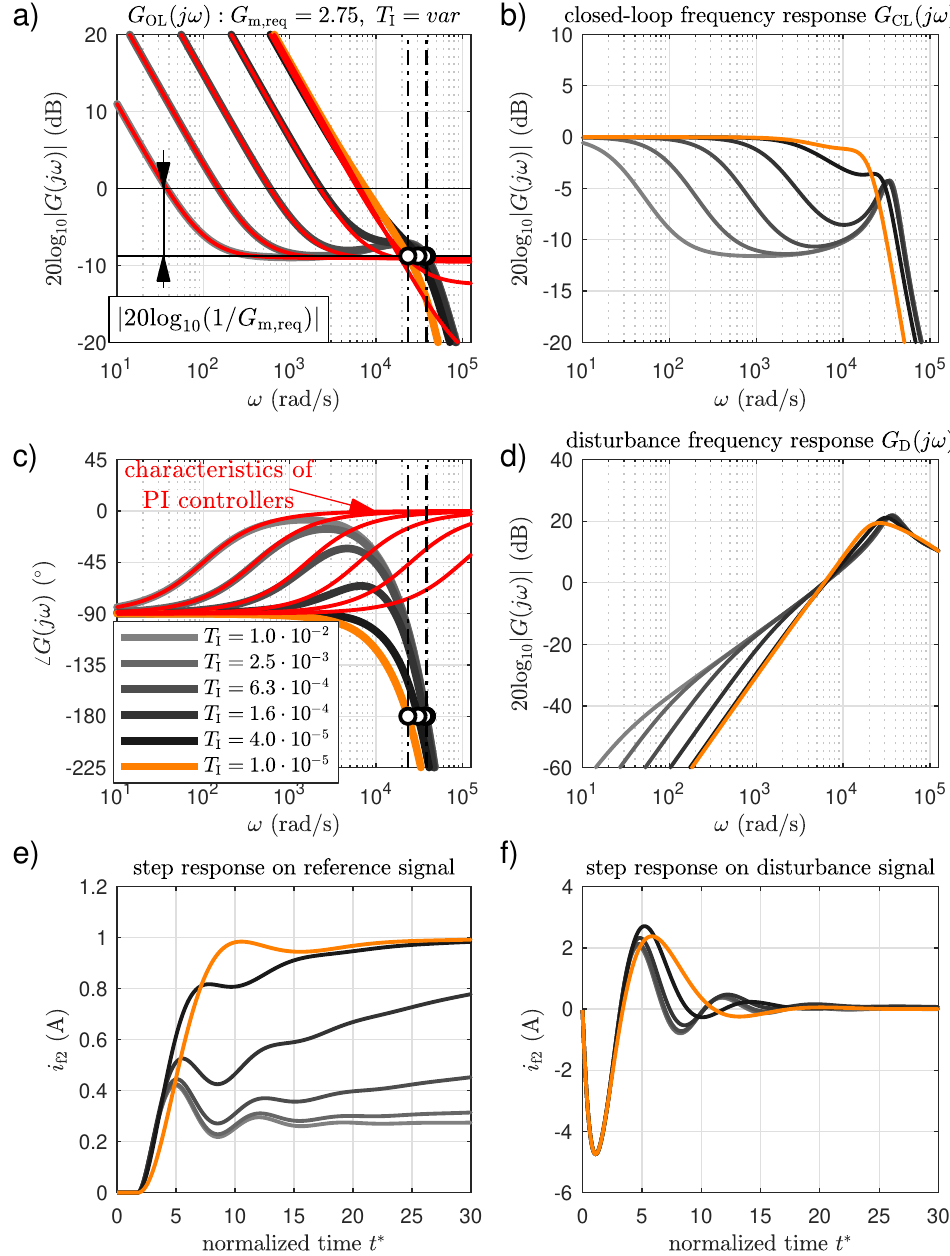
Figure 6. The current control loop characteristics at constant gain margin of G m,req = 2.75 and for various controller integral time T I values: ( a , c ) amplitude and phase Bode plots of the open-loop system frequency response, ( b ) amplitude Bode plot of the closed-loop system frequency response, ( d ) amplitude Bode plot of the disturbance frequency response of the system, ( e ) response of the system on a unit step of the reference signal, ( f ) response of the system on a unit step of the disturbance